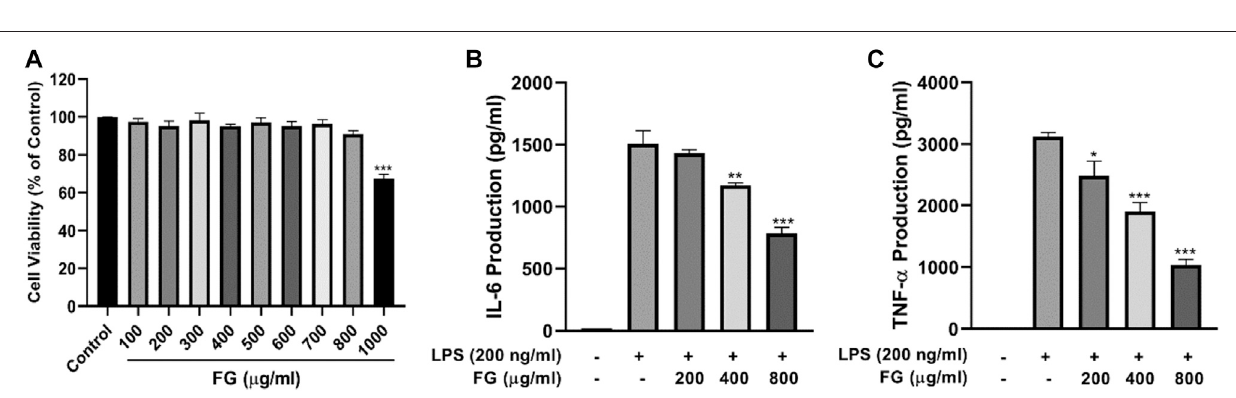
FIGURE 3 | Panel (3A): Effect of FG on cell viability of BV2 microglia. BV2 cells were treated with 100 – 1000 μ g/ml FG extraction for 24 h, and cell viability was evaluated using the MTT reduction assay. The results were expressed as the percentage of surviving cells in the control group. Each bar presents the mean ± SEM of threeindependentexperiments.Panel (3B,C) :EffectsofFGonTNF- α andIL-6productioninLPS-inducedBV2microglia.BV2cellsweretreatedwithFGextraction(200, 400, and800 μ g/ml)inthepresenceofLPS(200 ng/ml) for24 h. TNF- α and IL-6contentsincellculture supernatantswereevaluated usingELISAkits. Results are expressed as mean ± SEM of three independent experiments (* p < 0.05, ** p < 0.01, *** p < 0.001).